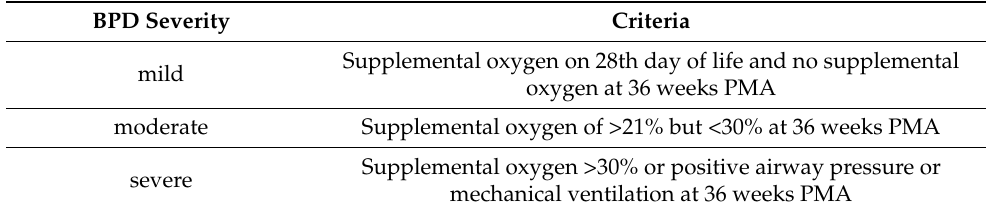
Table 1. Bronchopulmonary dysplasia (BPD) definition by the criteria of the National Institutes of Child Health and Human Development (NICHD)/National Heart, Lung, and Blood Institute (NHLBI) workshop of 2001 [3]. BPD Severity Criteria Supplemental oxygen on 28th day of life and no supplemental mild oxygen at 36 weeks PMA moderate Supplemental oxygen of >21% but <30% at 36 weeks PMA Supplemental oxygen >30% or positive airway pressure or severe mechanical ventilation at 36 weeks PMA PMA: postmenstrual